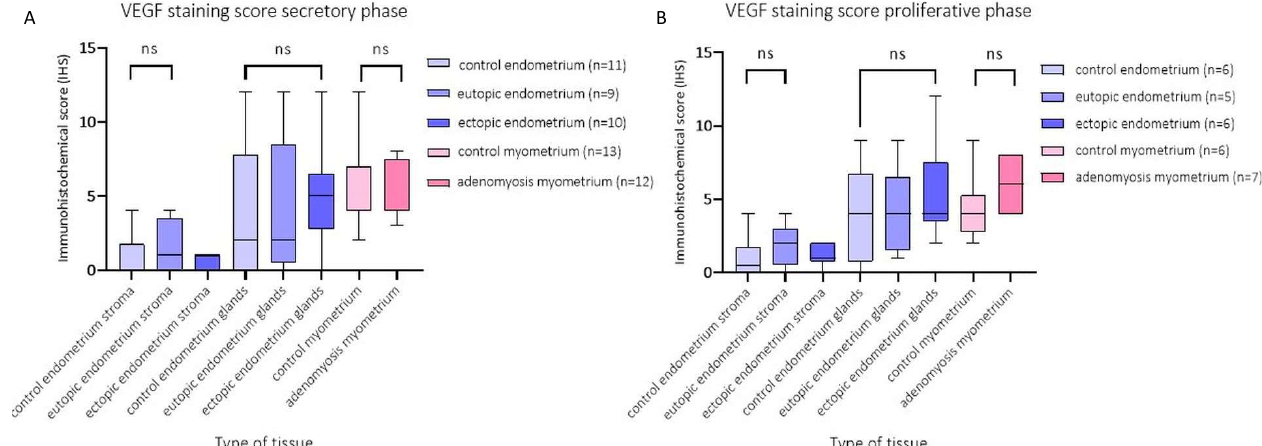
Figure 8. Boxplots of immunohistochemical score (IHS) of VEGF staining per tissue type in the secretory ( A ) and proliferative phase ( B ) in adenomyosis eutopic and ectopic endometrium stroma and glands ( n = 16) versus control endometrium stroma and glands ( n = 18), and in adenomyosis myometrium ( n = 19) versus control myometrium ( n = 18) (right). There were no significant differences in VEGF IHS in each tissue type between the adenomyosis and control patients. Data shown as median ± range. NS: not significant.